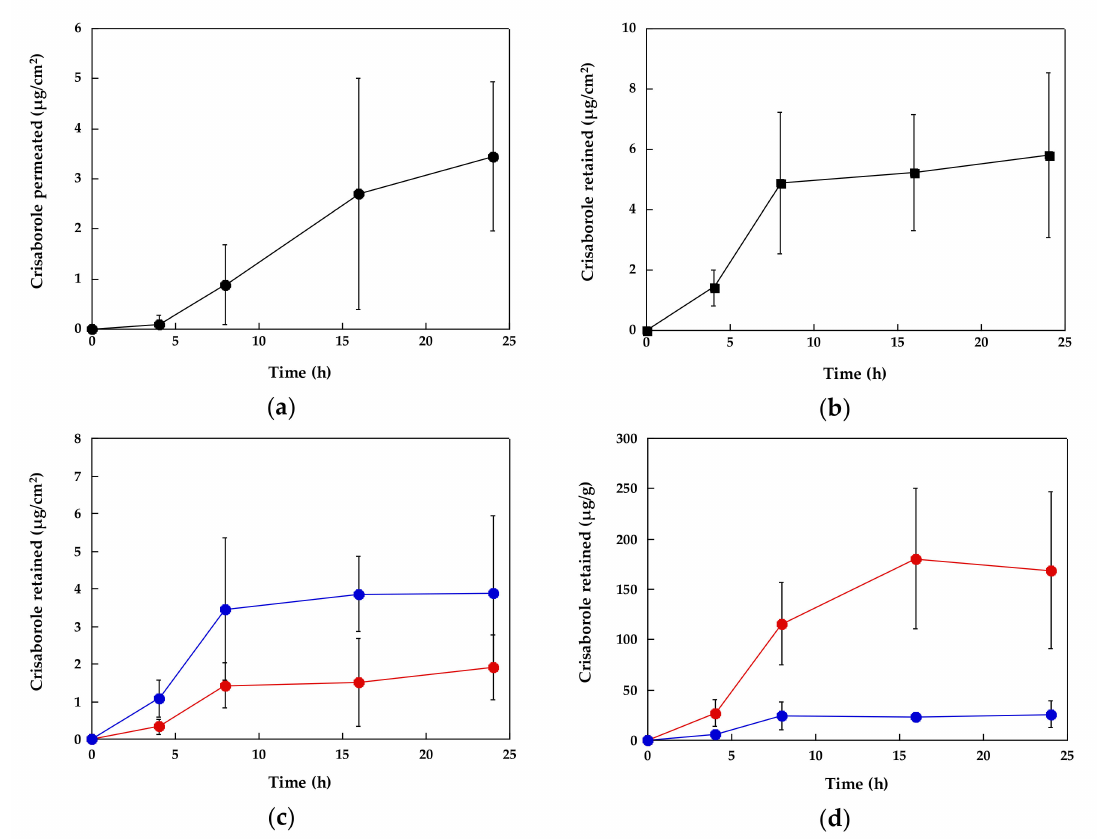
Figure 1. Crisaborole skin permeation ( a ) and total skin retention ( b ), and epidermis ( red line ) and dermis ( blue line ) retention expressed per unit surface ( c ) or per unit weight ( d ) after application of the ointment. Average values ±